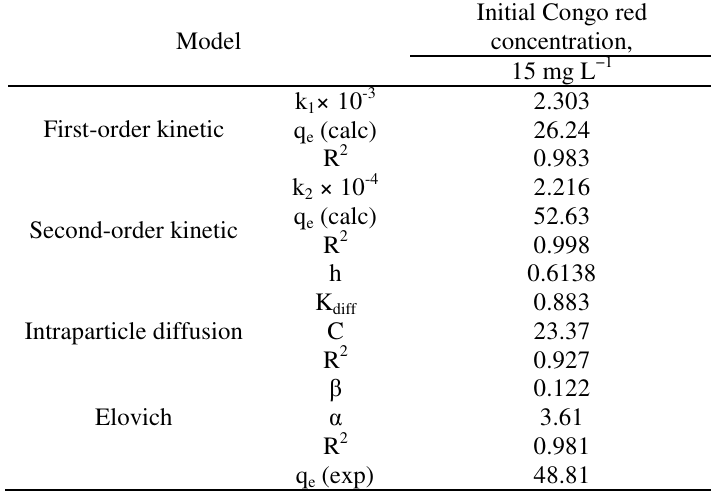
Table 2. Adsorption kinetic parameters at different initial Congo red onto 0.025 g of PtN- AC in 50 mL at pH 4, room temperature and congo red concentration of 15 mg L